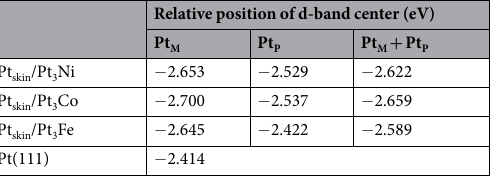
Table 1. Relative position of d-band centers of 1st layer Pt atoms with respect to the Fermi